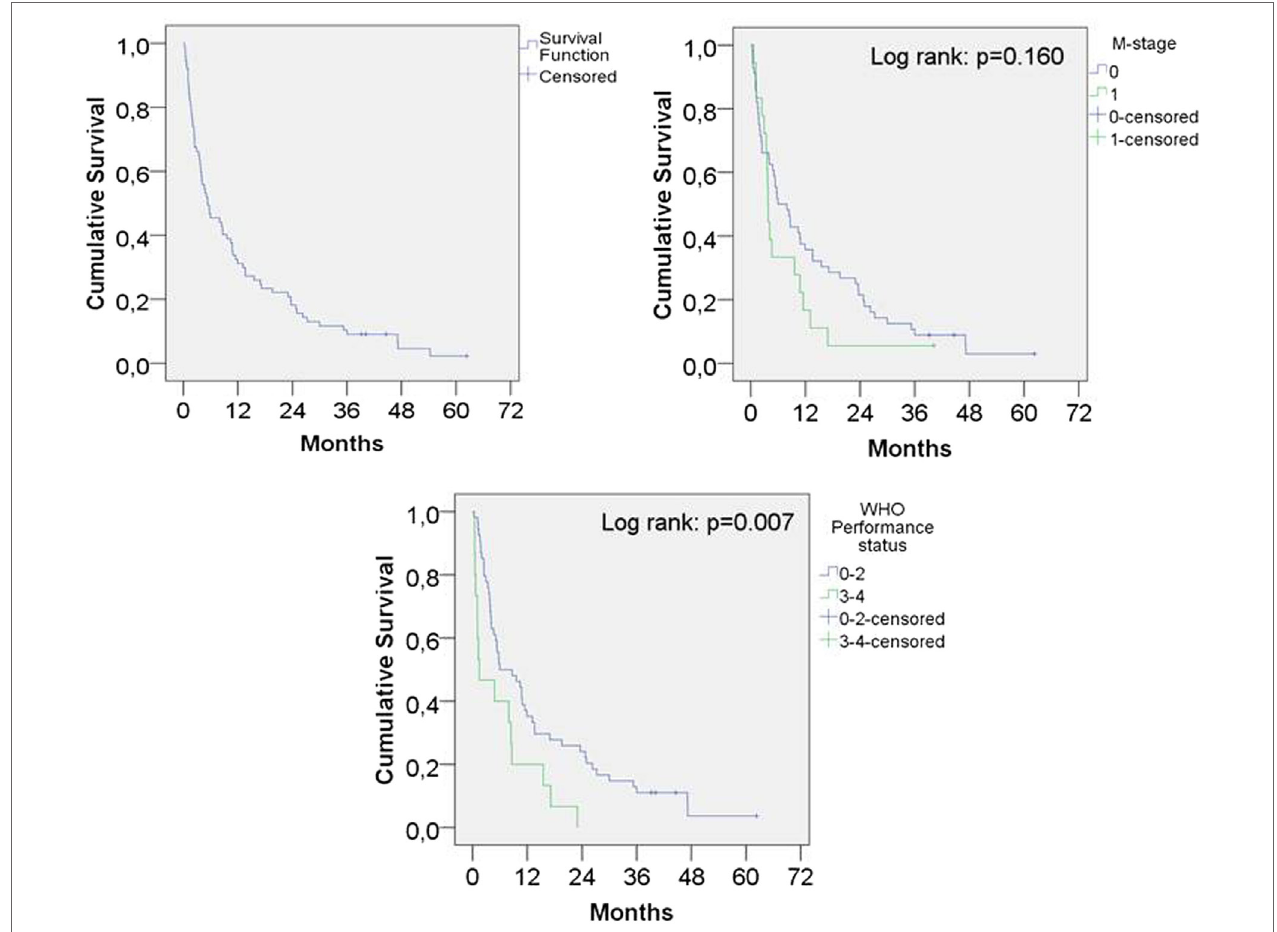
FigUre 1 | Kaplan–Meier survival function overall and according to presence of metastatic disease and performance